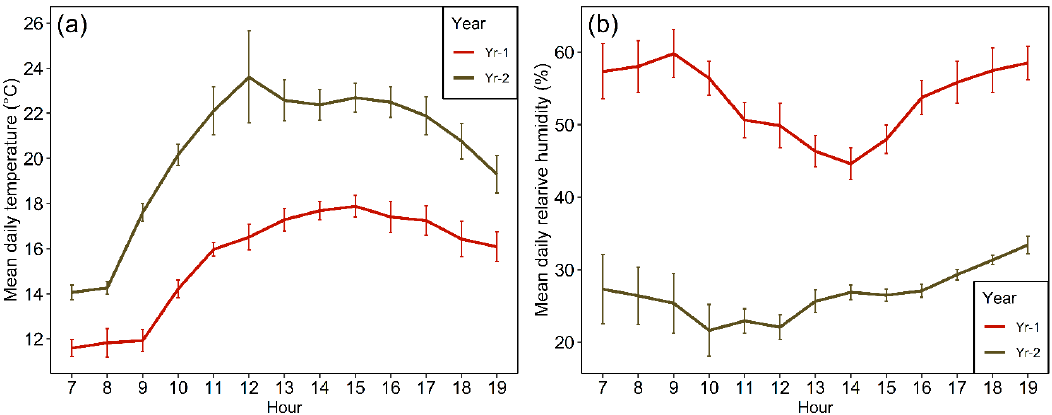
Figure 3. Average (+1SE) hourly daytime temperature ( a ) and relative humidity ( b ) between 7 h (7 a.m.) and 19 h (7 p.m.) standard time over the study periods in February 2019 (Yr-1) and 2020 (Yr-2) based on the authors’ onsite